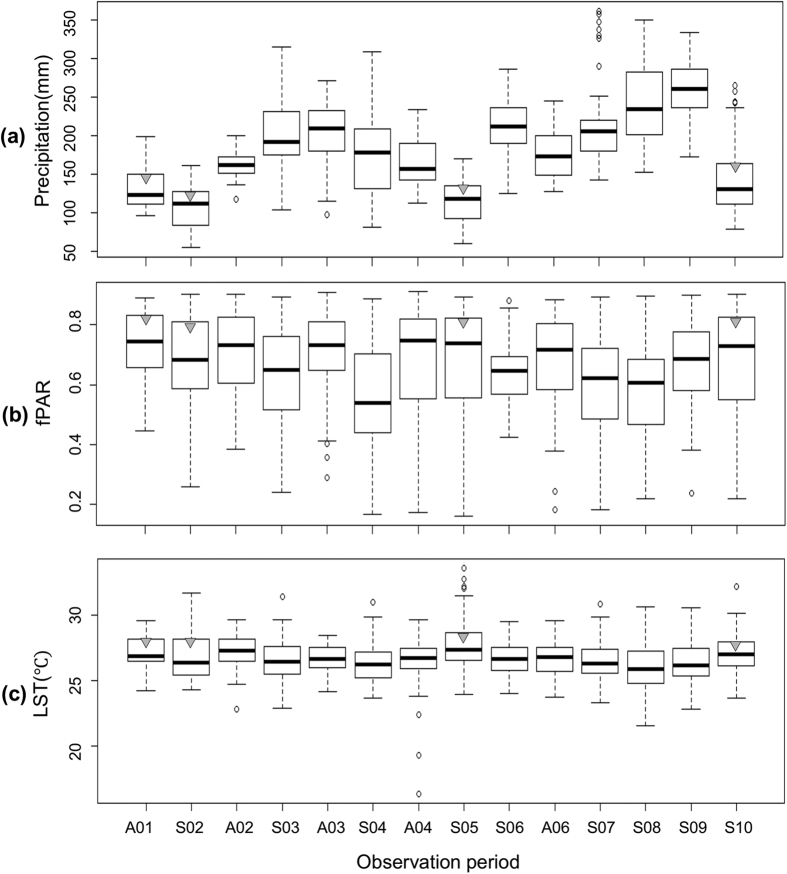
Timeline comparison of forest climatic conditions between large and local-scale GF: (a) precipitation; (b) fraction of photosynthetically active radiation (fPAR); and (c) land surface temperature (LST). The boxplot with the small triangle indicates large-scale GF.